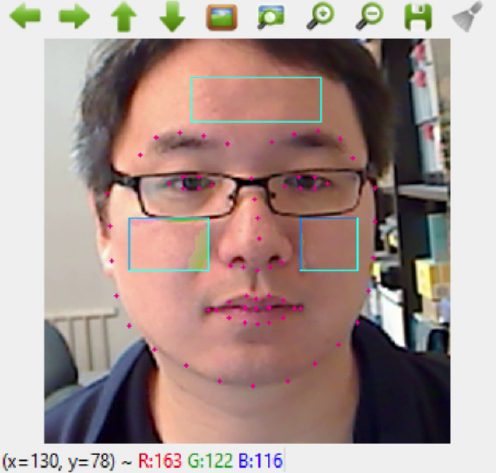
Figure 2. Captured ROIs using Dlib 68-point facial